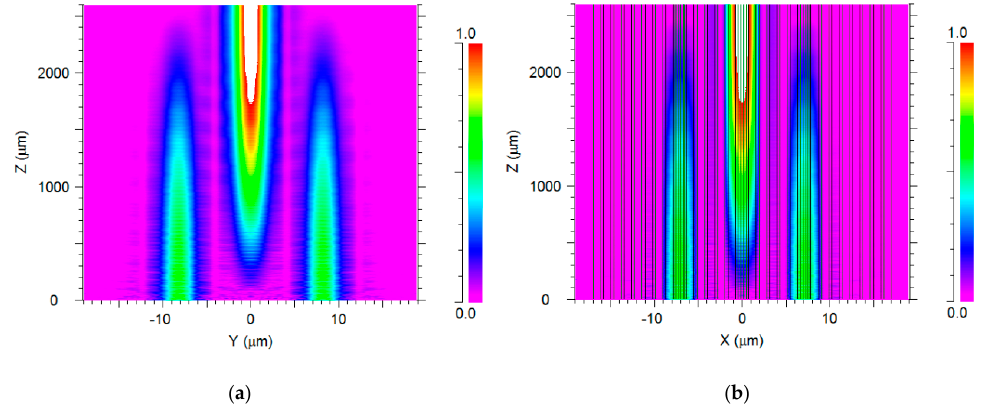
Figure 5. Two dimensional (2D) 2 × 1 power combiner of the optical signals ( λ = 1 µm): ( a ) yz plane; ( b ) xz plane.